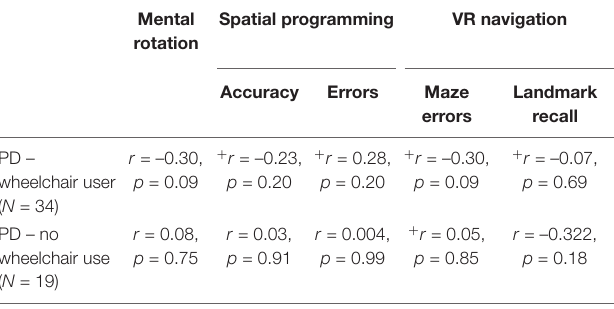
TABLE 4 | Correlations between Movement ABC checklist Total Motor Score and spatial variables, for each PD